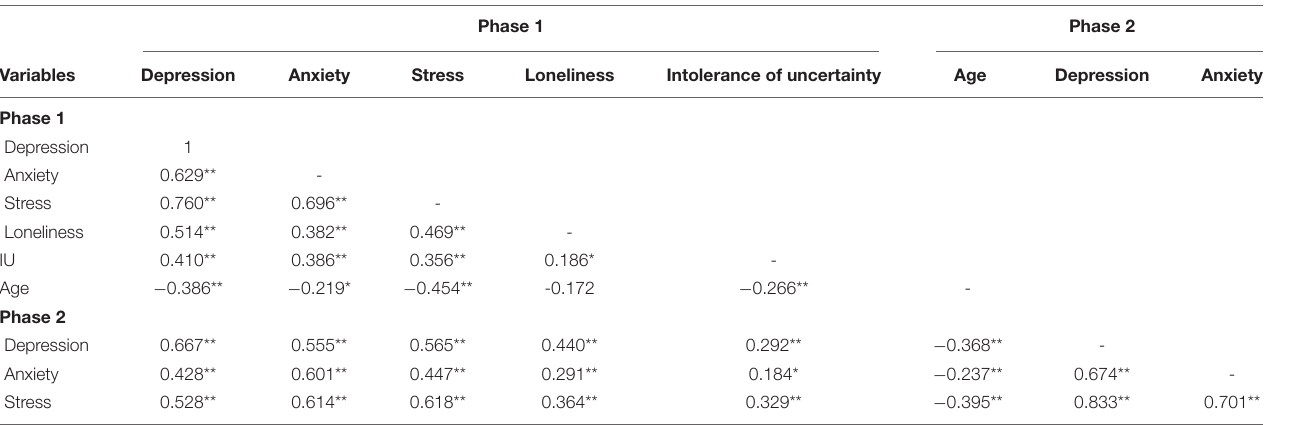
TABLE 5 | Correlation table for variables examined in phase